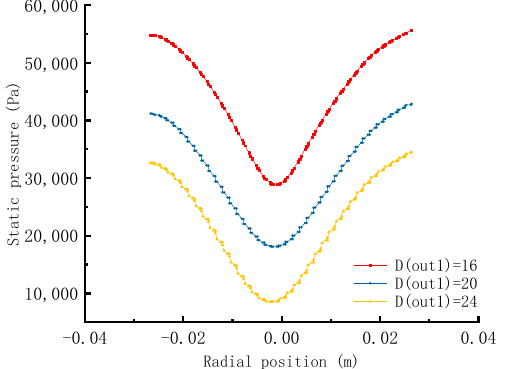
Figure 4. Static pressure distribution curve of section Z.